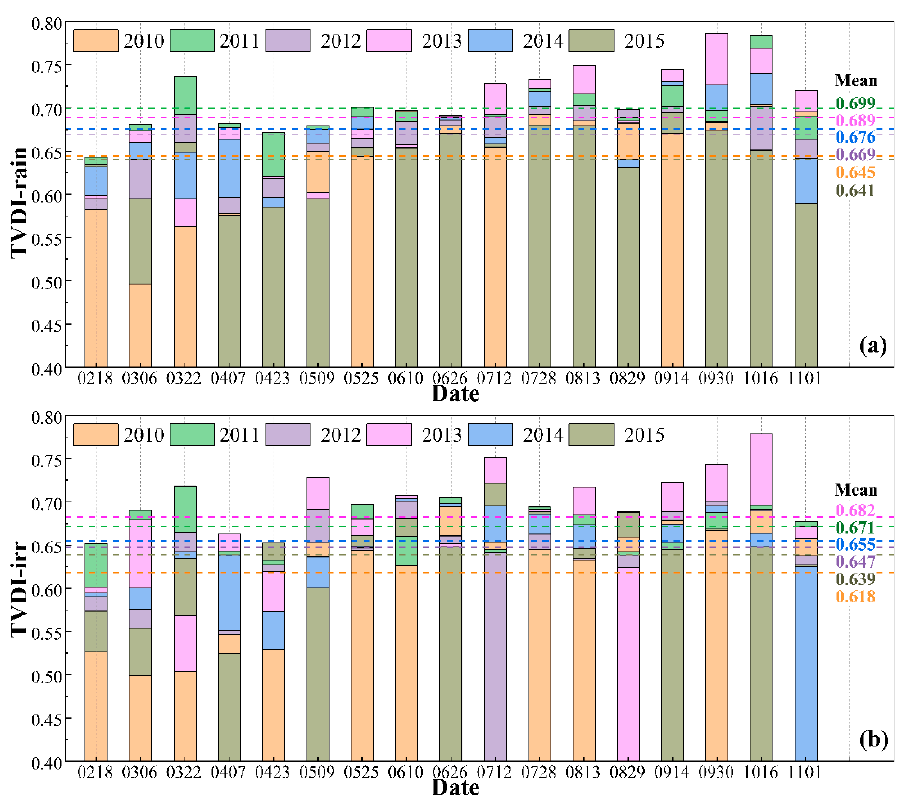
Figure 9. The average value of the TVDI in the middle and lower reaches of the Yangtze River from 2010 to 2015, with a temporal resolution of 16 days. The images without crop growth in January and December were removed. ( a ) The TVDI of rain-fed arable land (TVDI-rain). ( b ) The TVDI of irrigated arable land (TVDI-irr).